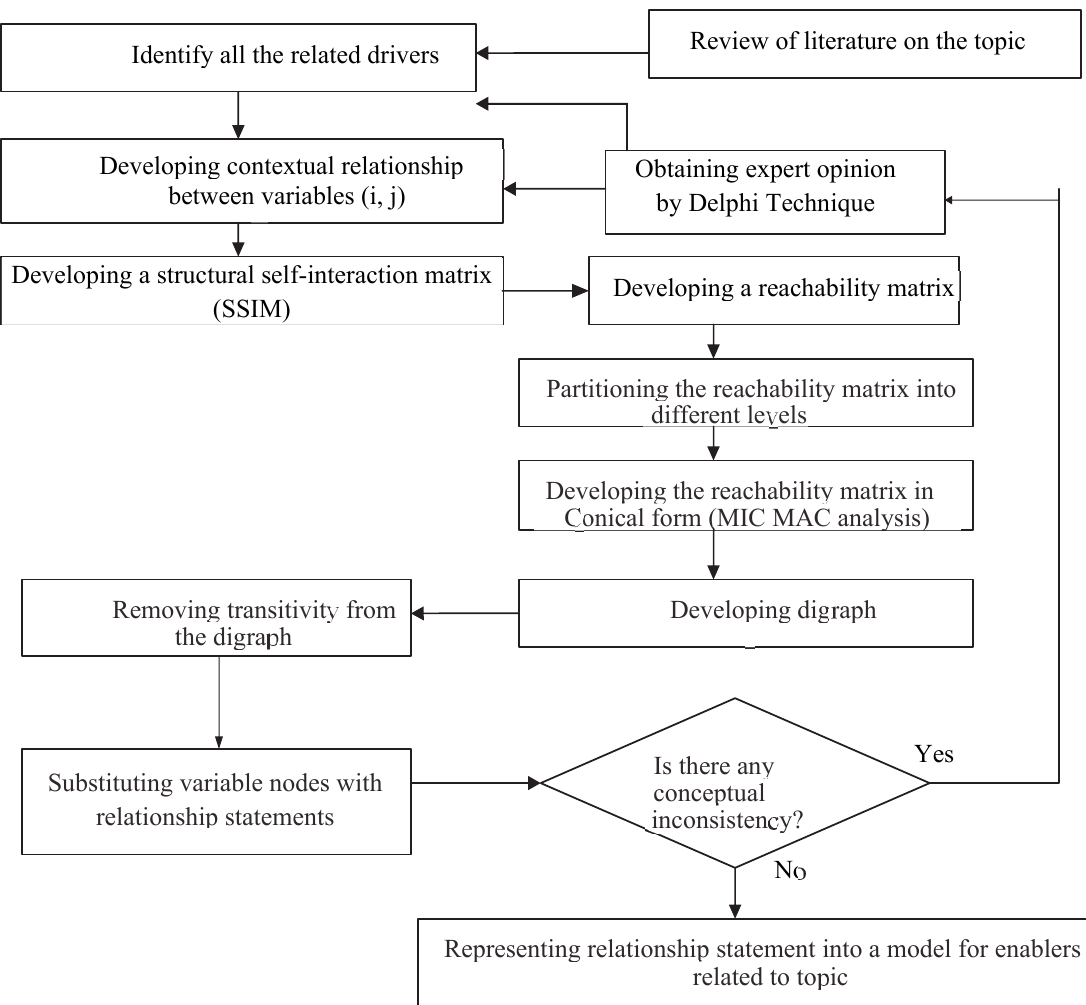
Fig. 1. Flow chart for developing ISM